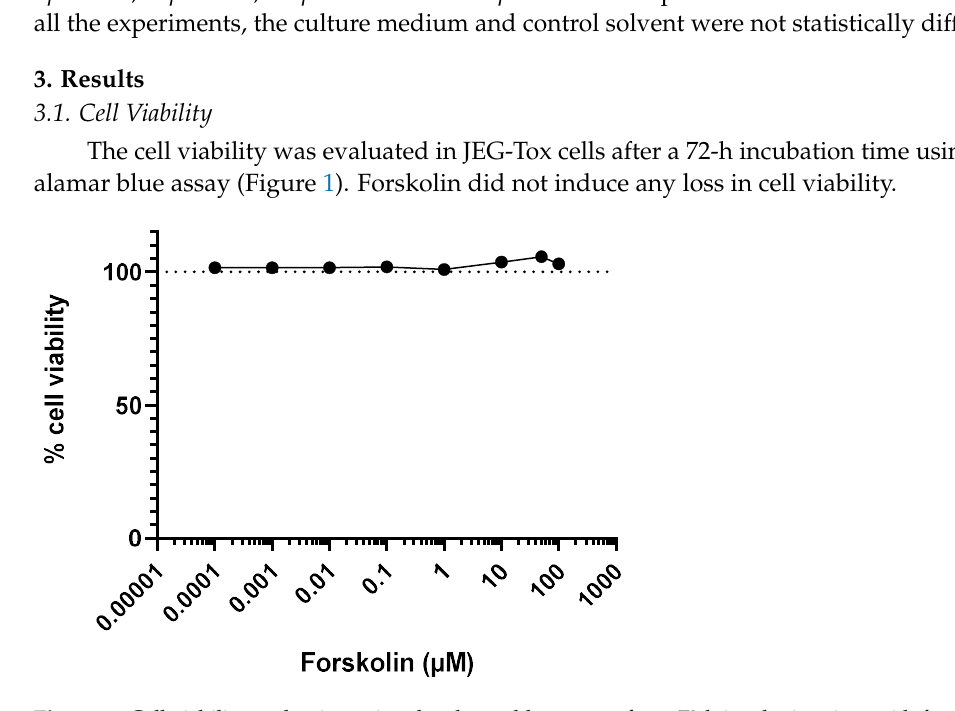
Figure 2. P2X7 receptor activation using the YO-PRO-1 assay after a 72-h incubation time with for- skolin. The dotted line represents the P2X7 receptor activation basal level. The significance threshold was **** p < 0.0001 compared to the culture medium. 3.3. Estradiol Secretion The estradiol secretion by JEG-Tox cells after a 72-h incubation time was quantified in cell supernatants. Forskolin induced a statistically significant raise in estradiol secretion from 0.1 µM: ×1.41 at 0.1 µM, ×1.47 at 1 µM, ×1.50 at 10 µM, ×1.60 at 50 µM and ×2.03 at 100 µM (Figure 3).